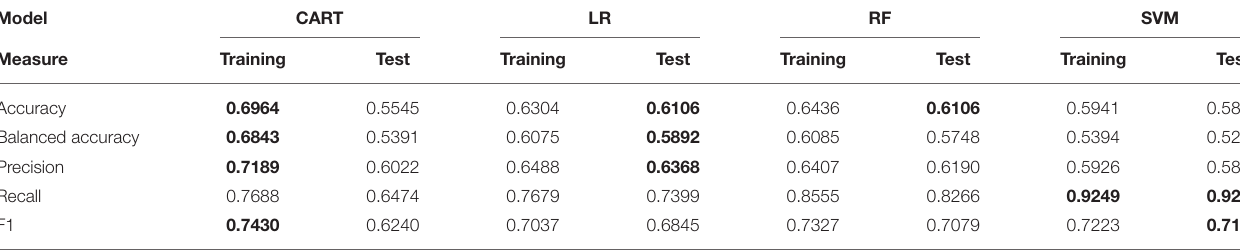
TABLE 5 | Performance evaluation results of zero-part models (classification task).